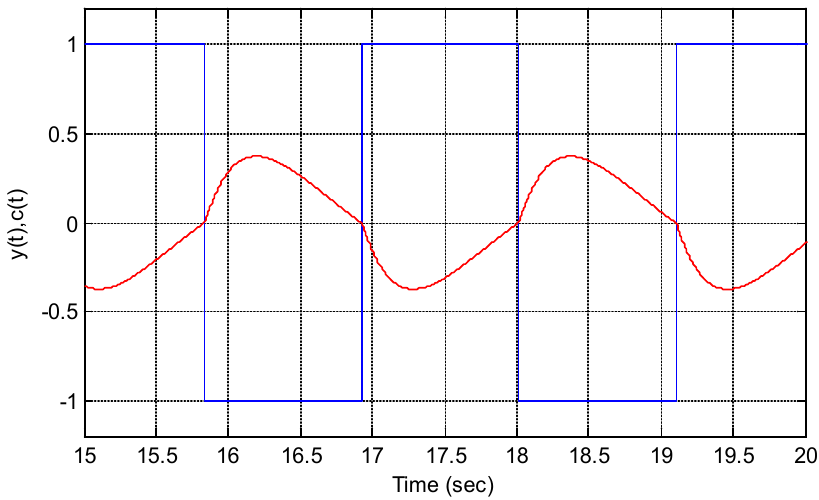
and ideal relay 𝐺 2 (𝑗𝜔)